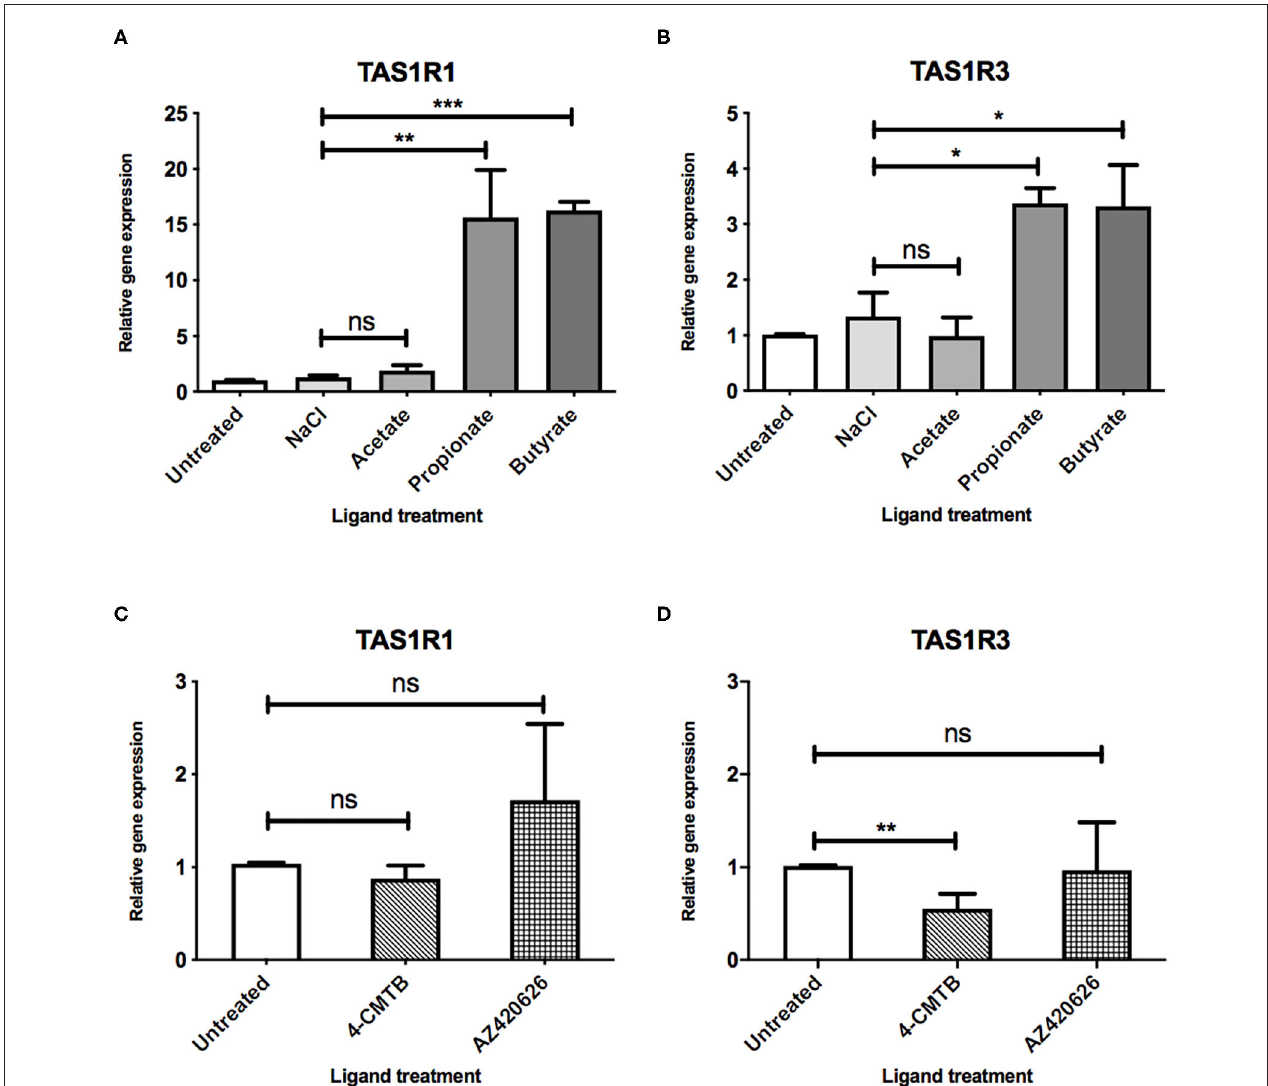
FIGURE 2 | SCFAs and synthetic ligands differ in their ability to upregulate the umami taste receptor. (A,B) STC-1 cells were incubated with NaCl or SCFAs (10mM) for 5h, after which, RNA was extracted and purified. Expression of taste receptors TAS1R1 (A) , TAS1R3 (B) was quantified using qPCR analysis and normalized to the levels of housekeeping gene β -actin. Data are expressed as mean ± SEM fold-change in expression over the untreated control ( n = 3). T -tests vs. control; ns, non-significant; * p < 0.05; ** p < 0.01; *** p < 0.001. (C,D) STC-1 cells were incubated with either 4-CMTB or AZ420626 (10 µ M) for 5h, after which, RNA was extracted and purified. Expression of taste receptors TAS1R1 (C) , TAS1R3 (D) was quantified using qPCR analysis and normalized to the levels of housekeeping gene β -actin. Data are expressed as mean ± SEM fold change in expression over the untreated control ( n = 3). Unpaired t -tests vs. control; ns, non-significant; * p < 0.05; ** p < 0.01; *** p <